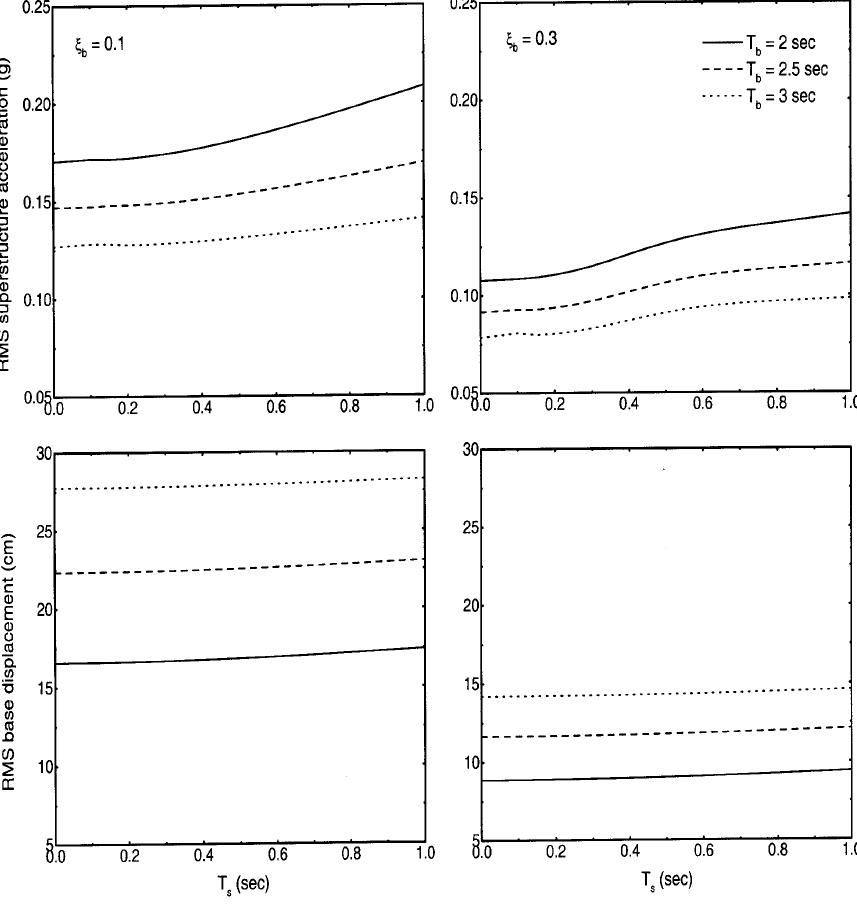
Fig. 7. Effects of the superstructure flexibility on the peak response of structure isolated by the LRB